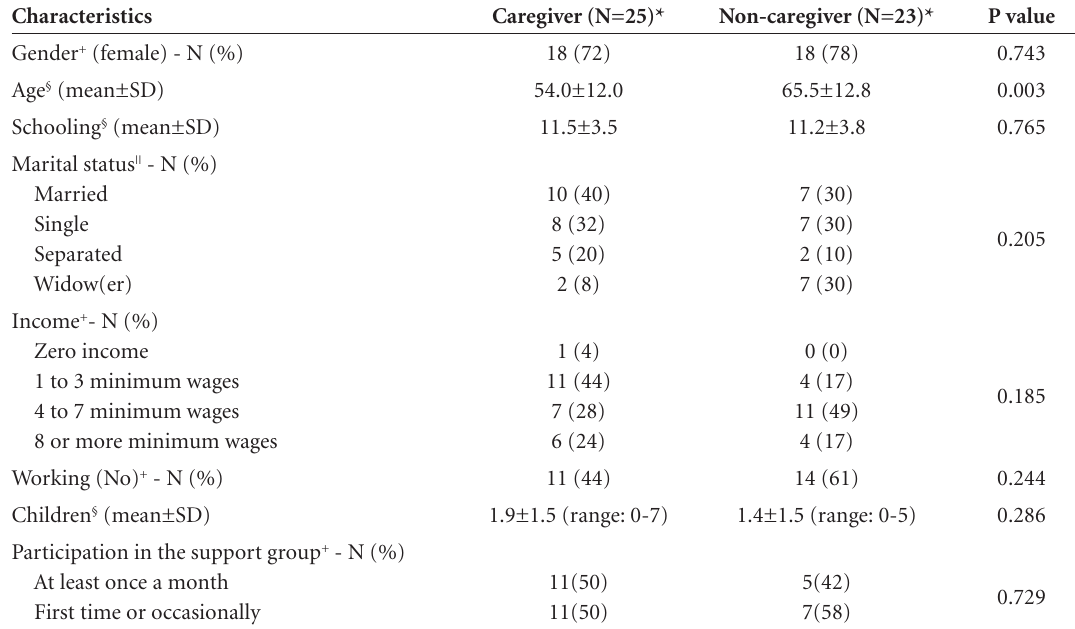
Table 1. Characteristics of caregivers and